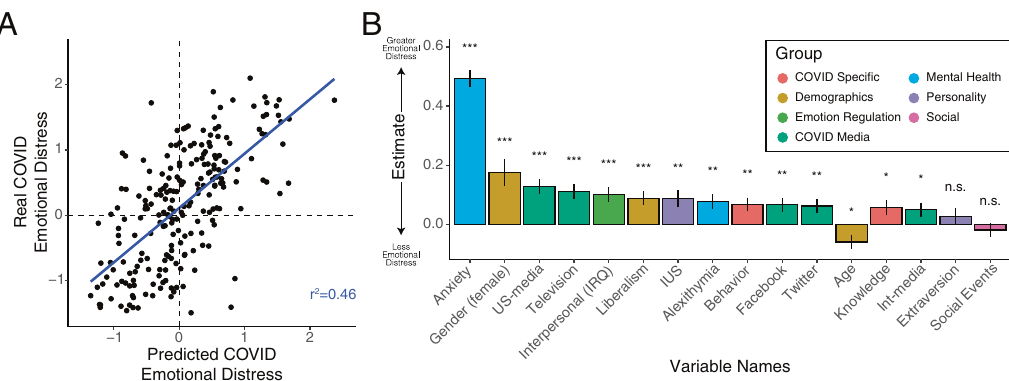
Fig. 3 Cross-validation model results. The x -axis shows the predicted COVID-19 emotion distress ratings from a held-out dataset while the y -axis shows the real ratings. The variance explained by the model is r 2 = 0.46 and the model ’ s calibration (slope of the blue line) is close to 1 ( β = 0.95 ± 0.07, t (234) = 14.02, p < 0.001). B Variable importance in the CV model. Estimates re fl ect standardized beta coef fi cients and are ordered based on the absolute value of the estimate. Error bars re fl ect beta coef fi cient standard errors.